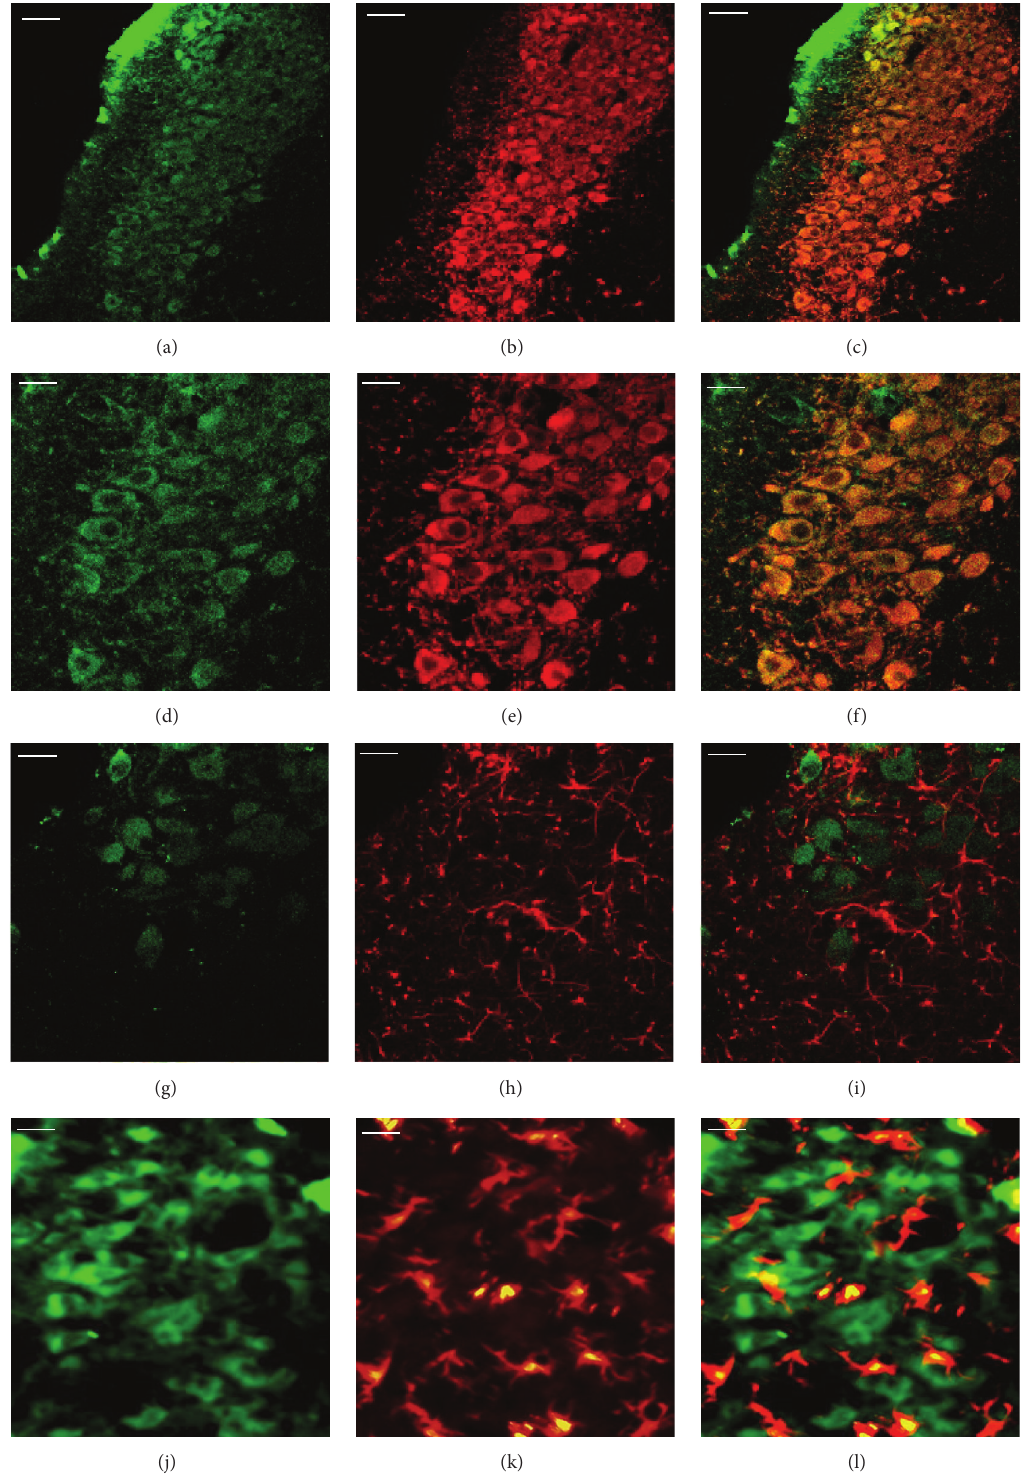
Figure 4: Characterization of IL-4-producing cells in the LC. (a–c) Representative fluorescent images showed that IL-4-secreting cells (a) were colocalized (c) with TH-releasing cells (b). Photomicrographs were taken at × 200 magnification. Scale bars = 50 𝜇 m. (d–f) High power (taken at × 400 magnification) photographs of (a), (b), and (c), respectively, are shown. Scale bars = 20 𝜇 m. IL-4-releasing cells (g and j) were not merged (i and l) with GFAP-positive cells (h) or Iba-1-immunoreactive cells (k). Photomicrographs were taken at × 400 magnification. Scale bars = 20 𝜇